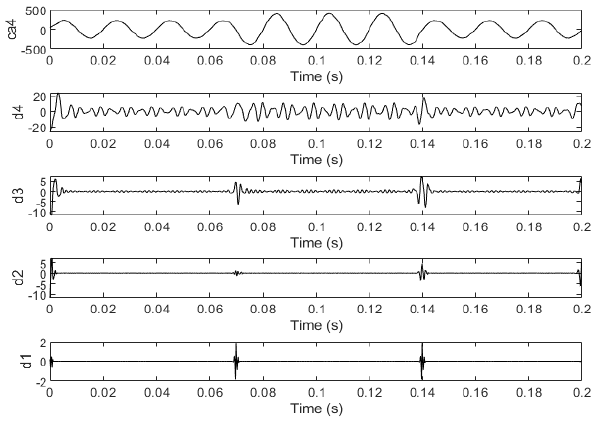
Figure 21. Voltage swell.